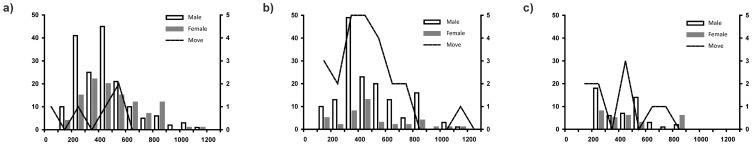
Relationship between number of Sympetrum depressiusculum (both sexes) and distance from the natal site, and graphical representation of recorded movements of marked adults (“Move”) according to distance.A) 7 July–8 August 2012; B) 9 August–6 September 2012; C) 7 September–10 October 2012.